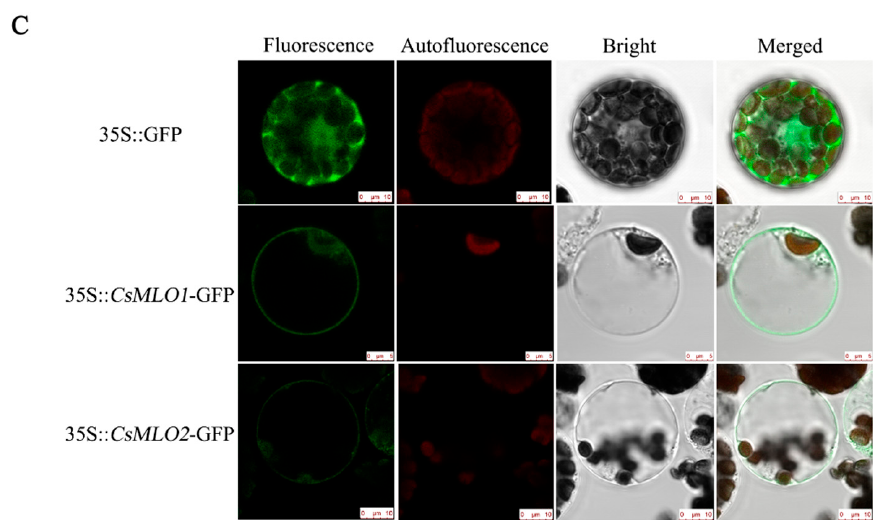
Figure 1. CsMLO1 - and CsMLO2 -overexpressing constructs in cucumber cotyledons. ( A ) Schematic of the CsMLO1-GFP and CsMLO2-GFP constructs. PCR identification of CsMLO1 and CsMLO2 genetically modified of cucumber was successful. Vector, recombinant plasmid; Plant, nontransgenic cucumber; 35S::GFP, empty vector; 35S:: CsMLO1 -GFP, CsMLO1 -overexpressing in cucumbers; 35S:: CsMLO2 -GFP, CsMLO2 -overexpressing in cucumbers; ( B ) Transgenic plants were identified by RT-qPCR. Data are the means ± standard deviations from three independent experiments, and each column represents a sample containing three cucumber cotyledons from di ff erent plants. Expression analysis of candidate genes using the 2 − ∆∆ Ct method. The asterisks indicate a significant di ff erence (Student’s t test, ** P < 0.01). ( C ) Green fluorescence protein (GFP) was detected in the cucumber protoplasts of the 35S::GFP, 35S:: CsMLO1 -GFP and 35S:: CsMLO2 -GFP constructs. Transient expression in the protoplasts of cucumber cells of 35S:: CsMLO1 -GFP and 35S:: CsMLO2 -GFP were primarily localized in the plasma membrane. Fluorescence, chloroplast autofluorescence, bright field and merged images were obtained using a Leica confocal microscope. Scale bars = 10 μ m.